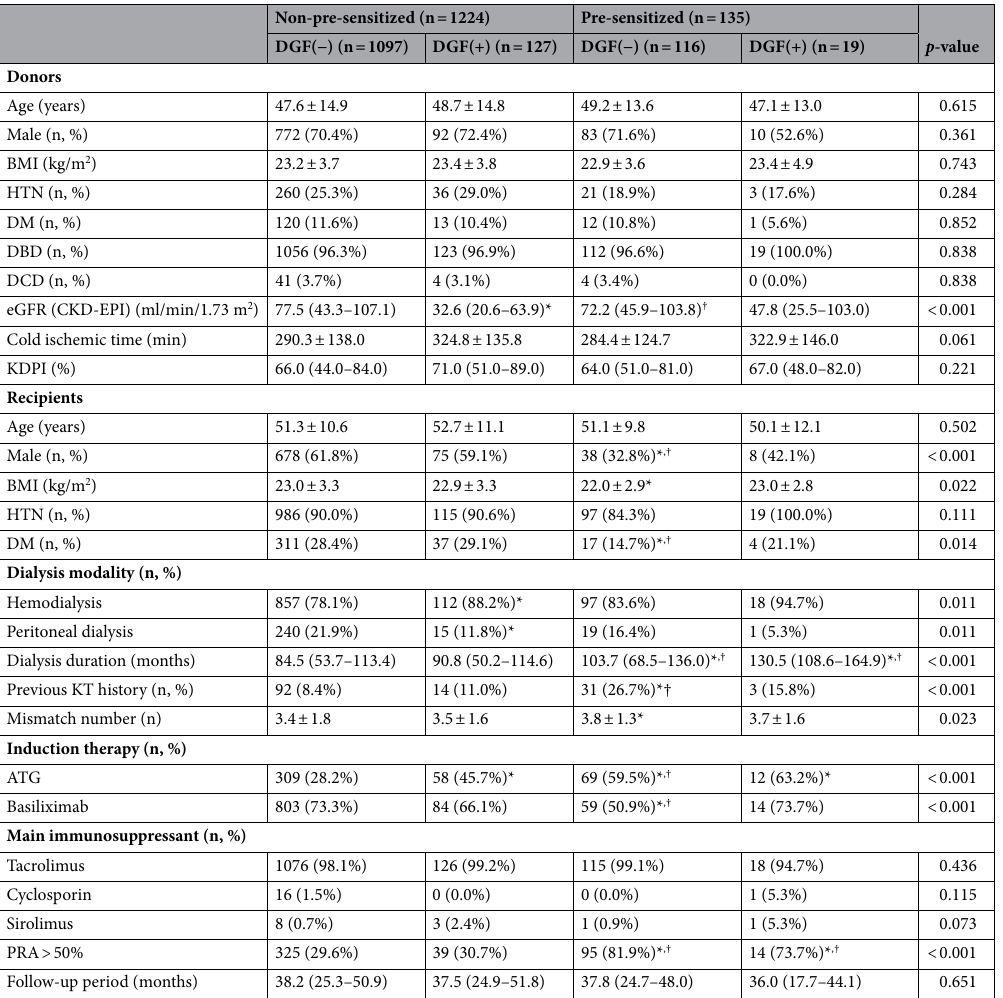
Table 1. Comparison of clinical and laboratory parameters among the 4 subgroups according to DGF and pre-sensitization status. Continuous variables are shown as mean ± standard deviation or median with interquartile range. Categorical variables are shown as number (proportions). DGF delayed graft function, BMI body mass index, HTN hypertension, DM diabetes mellitus, DBD donor after brain death, DCD